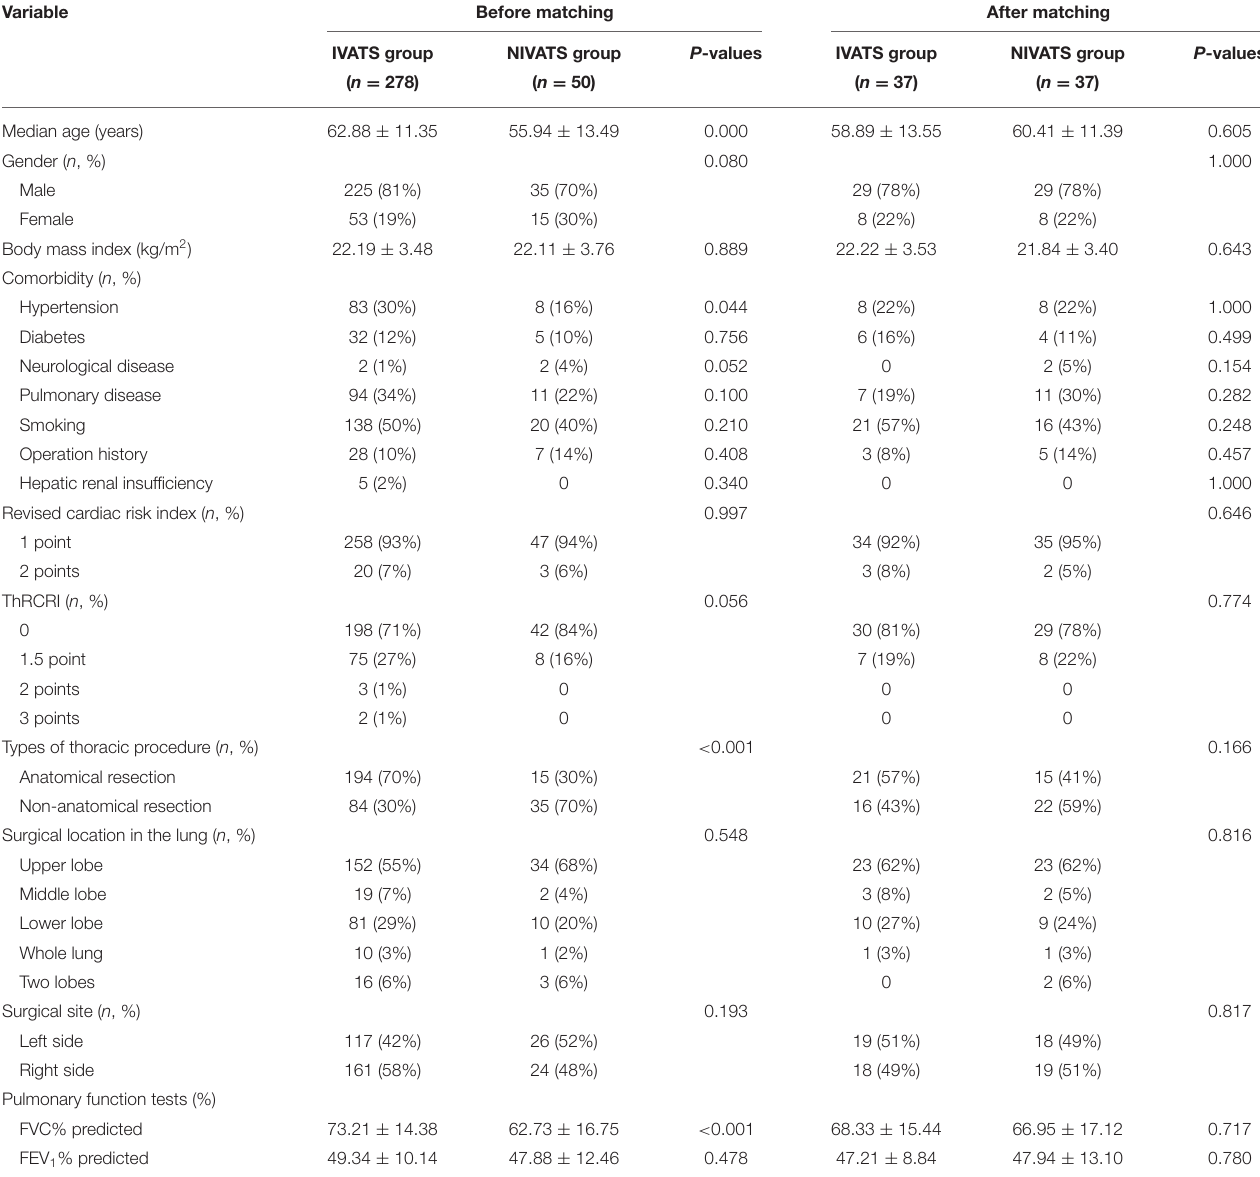
TABLE 1 | Demographic and clinical